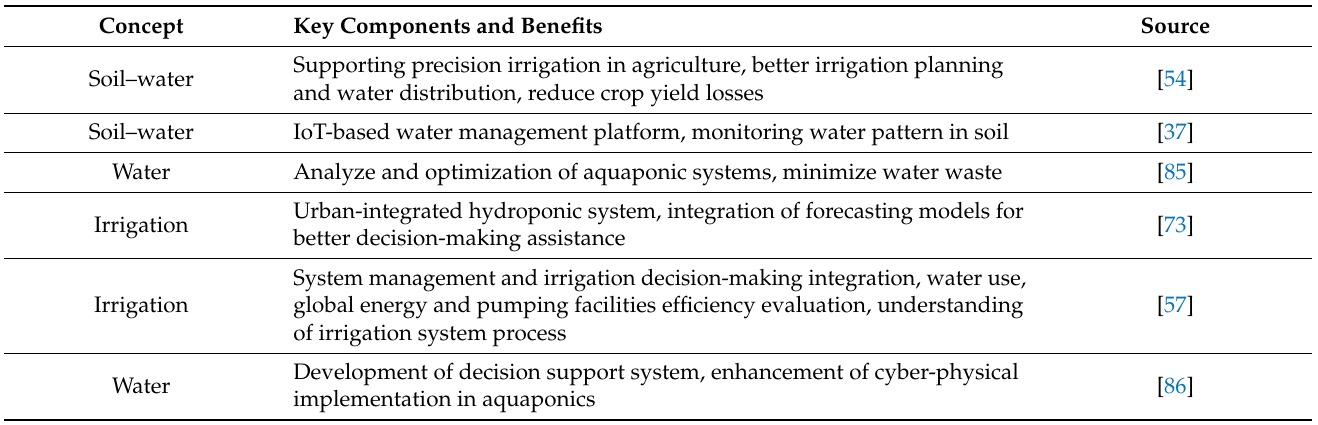
Table 2. Summary of soil and irrigation digital twin